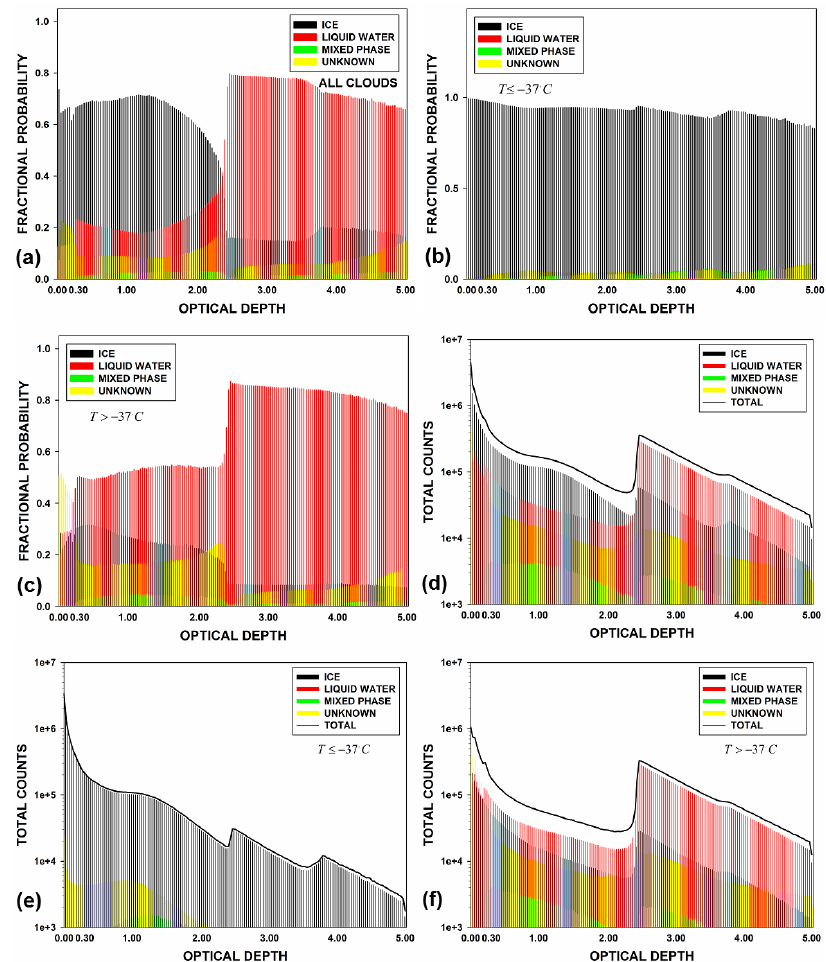
Figure 6. Fractional phase probabilities (ice, liquid water, mixed phase and unknown) in 0.03 cloud optical-depth intervals (532nm) between 0.00 and 5.00 for 2012 CALIOP V3.02 L2_CPro-5km clouds: (a) for all global cases and temperatures, (b) for all global cases for cloud top temperature < − 37 ◦ C, (c) for all global cases for cloud top temperature > − 37 ◦ C, and (d–f) total counts per cloud phase type in 0.03 optical-depth intervals from the global sample corresponding with (a–c)